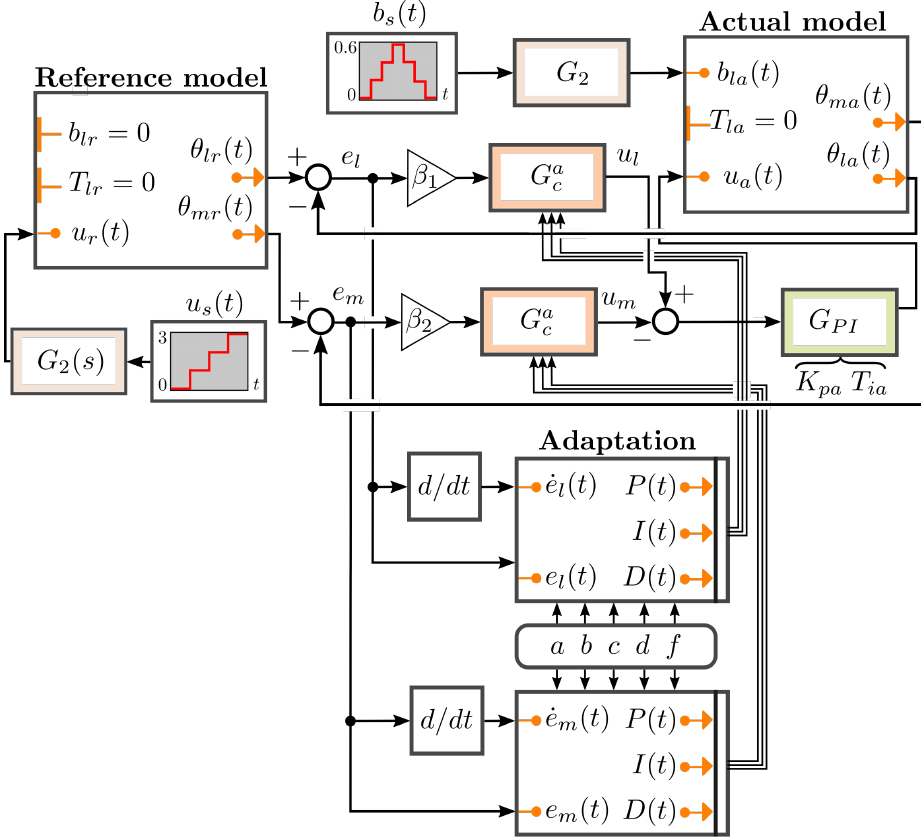
Figure 4. Block diagram of the closed-loop model reference adaptive PID (fractional PID, as well) control system with the additional time-dependent disturbances of the damping coefficient b la ( t ) , and a PI compensation of the resulting second-stage error